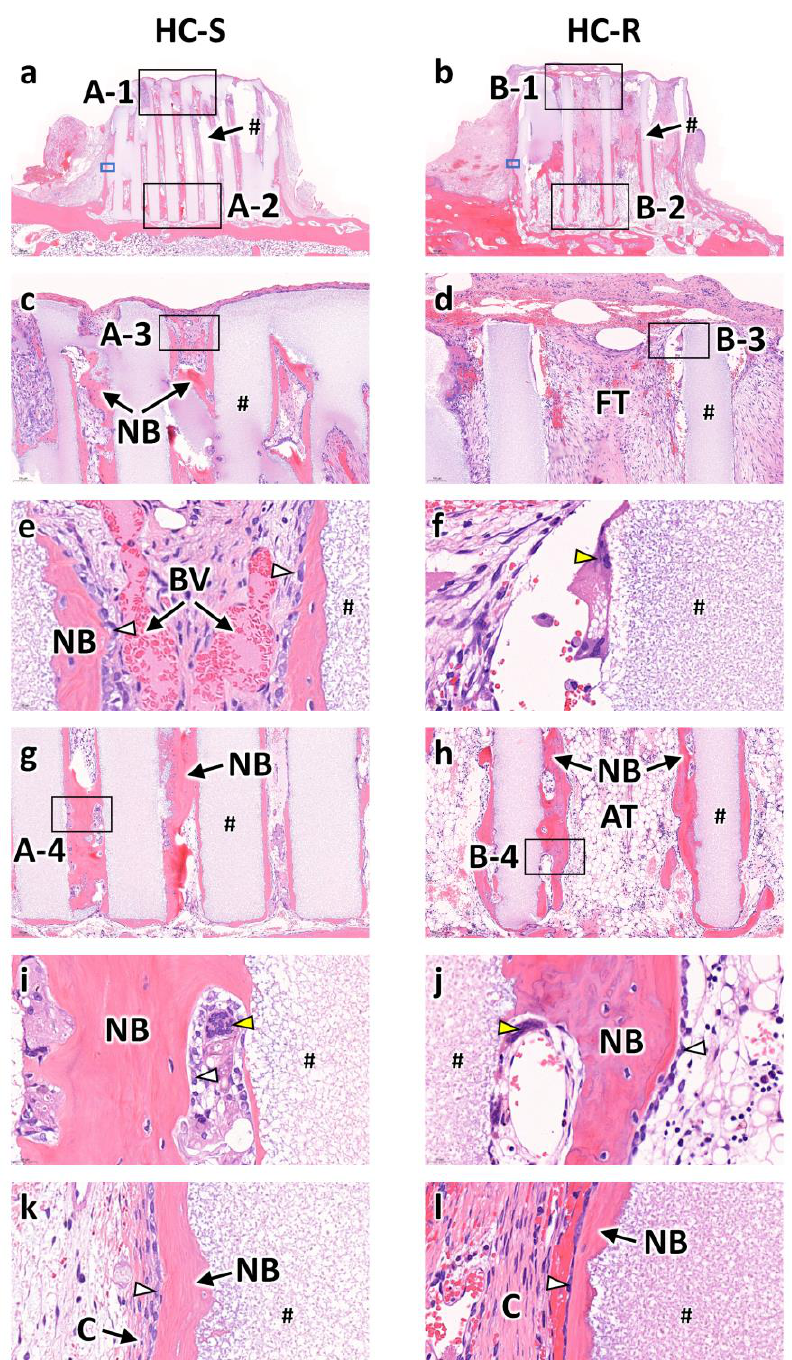
Figure 3. Hematoxylin and eosin (H&E)-stained sections at 4 weeks after implantation of honeycomb scaffolds with square channels (HC-S) ( a ) and honeycomb scaffolds with rectangle channels (HC-R) ( b ) on the rabbit calvaria. High magnification images of regions A-1 ( c ), B-1 ( d ), A-3 ( e ), B-3 ( f ), A-2 ( g ), B-2 ( h ), A-4 ( i ), and B-4 ( j ). High magnification images of regions enclosed in blue squares in Figure 3k ( k ) and Figure 3l ( l ). #, NB, FT, BV, AT, and C indicate scaffold strut, new bone, fibrous tissue, blood vessel, adipose tissue, and collagen fiber, respectively. White and yellow arrowheads indicate osteoblasts and osteoclasts, respectively.